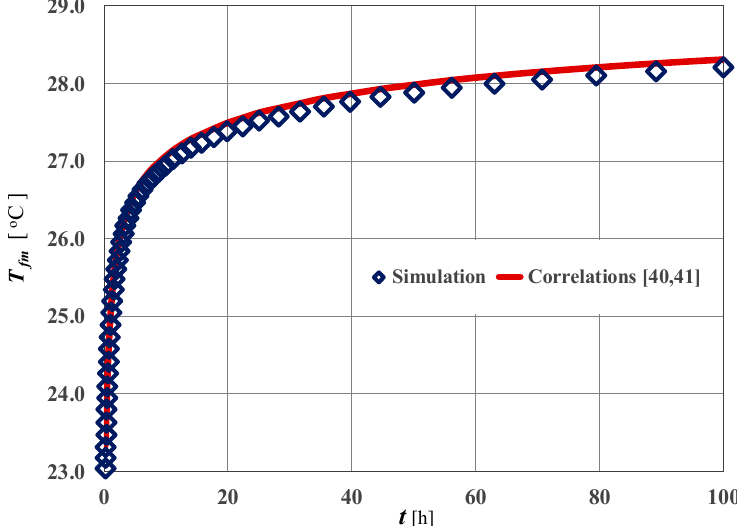
Figure 4. Comparison of the time evolution T f,m obtained through the numerical simulation and that determined by applying the correlations.